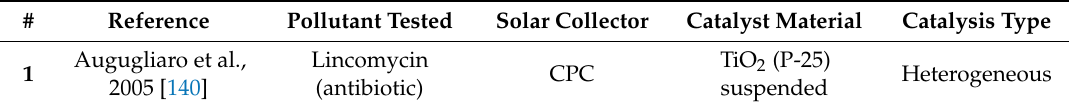
Table 6. BROCs model wastewaters (Pharmaceuticals).